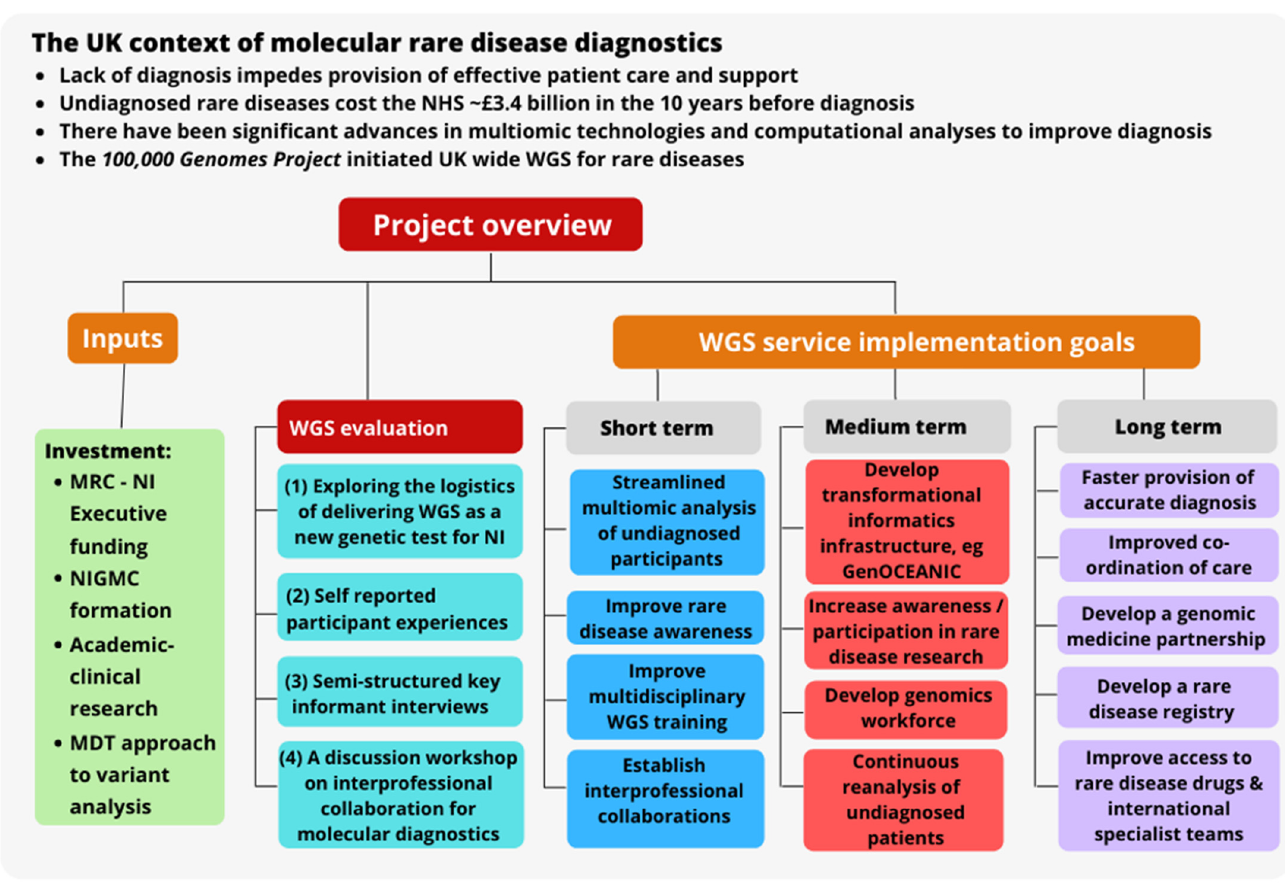
Figure 1. Project implementation overview. Abbreviations: multidisciplinary team (MDT), medical research council (MRC), National Health Service (NHS), Northern Ireland (NI) whole genome sequencing (WGS), United Kingdom (UK).